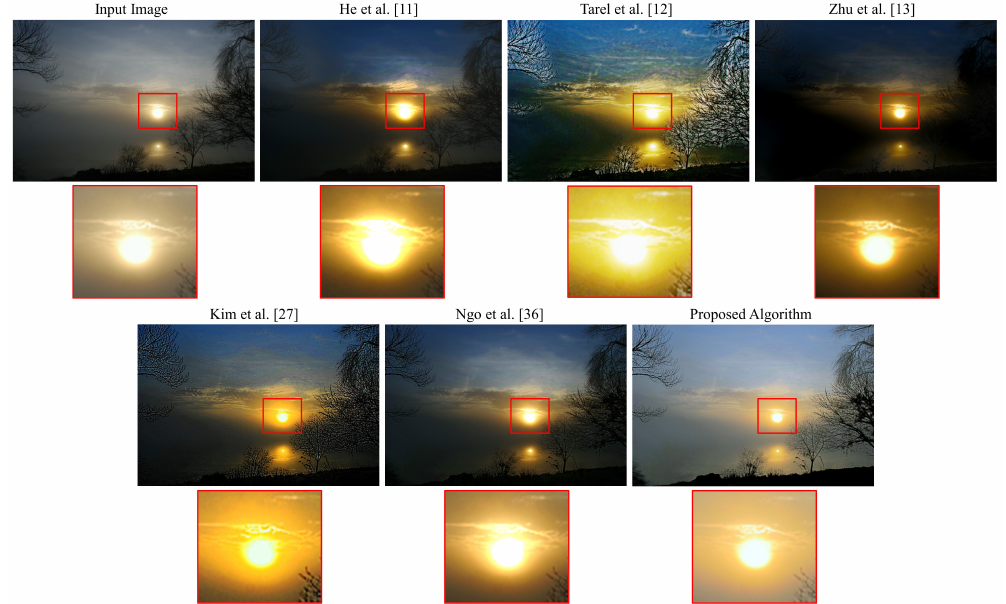
Figure 12. Qualitative assessment of the outputs produced by different algorithms on an image of a sunset.